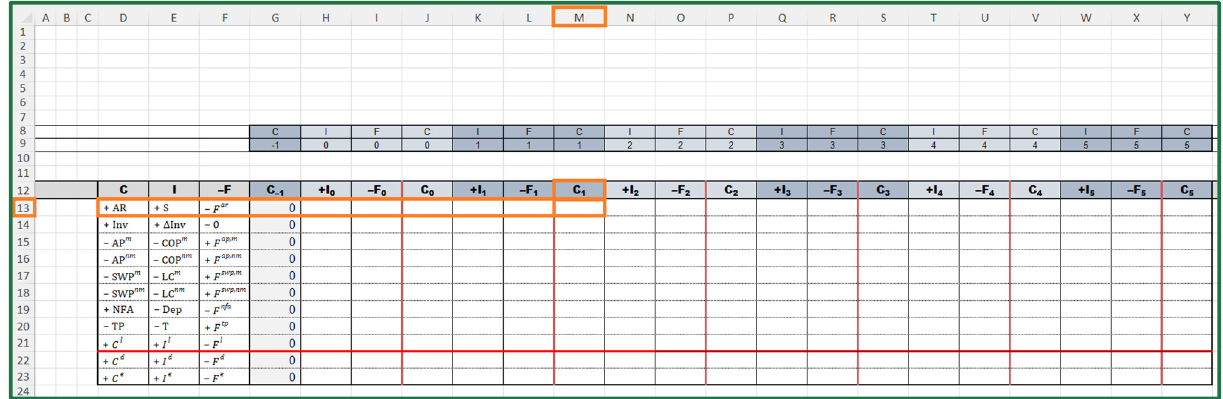
Figure 9. Cell M13 will contain the Accounts Receivable at 𝑡 = 1 (“SplitScreenStrip” sheet) To build the whole split-screen film, one must follow two steps: